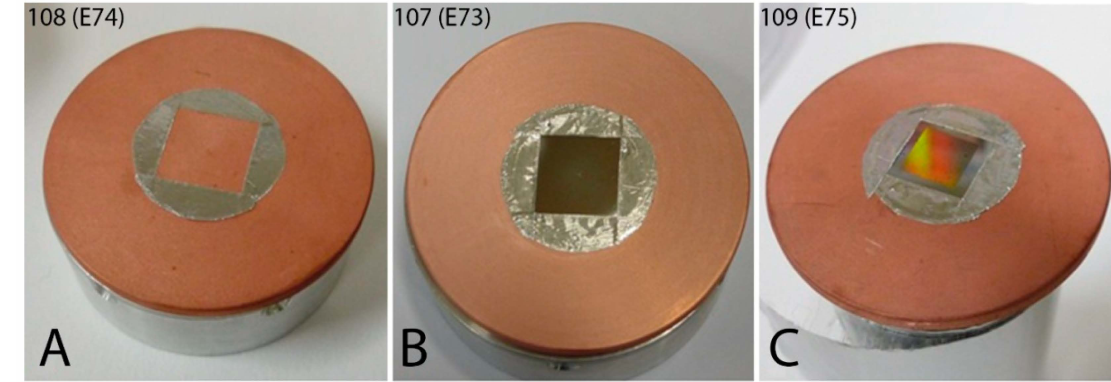
Figure 10. Samples for emissivity measurement and subsequent correlation: ( A ) Cu carrier with Al tape; ( B ) Cu carrier with pure tungsten sample and Al tape; ( C ) Cu carrier with tungsten sample with structure and Al tape. Adapted from [15] with kind permission of Brno University of Technology.